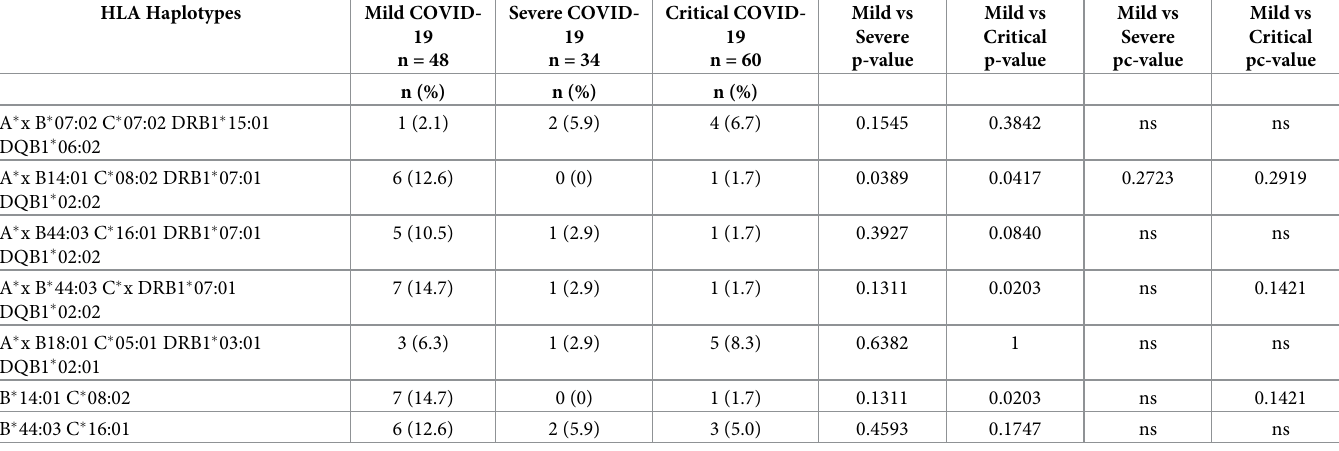
of fifteen KIR loci and two pseudogenes in the groups of individuals with severe and critical COVID-19 in comparison with the group of individuals with mild COVID-19 (Table 5). Association between HLA-C alleles and COVID-19 presentations Some HLA-C alleles can be divided into two large groups according to the amino acids located at positions 77 and 80 when they are considered as ligands for KIRs. Alleles from group C1 contain Ser 77 and Asn 80 (HLA-C � 01; � 03; � 08; � 12; � 14, and � 16), whereas alleles from group C2 contain Asn 77 and Lys 80 (HLA-C � 02; � 04; � 05; � 06; � 07; � 15; � 17, and � 18) [29]. When the frequency of hetero- and homozygosis of HLA-C1 and/or -C2 alleles was analyzed in the Table 4. Most common HLA haplotypes observed in individuals with mild, severe and critical COVID-19. The statistical significance of the comparisons between the frequencies of these haplotypes in the groups of individuals with severe and critical COVID-19 and the group of individuals with mild COVID-19 was calculated using HLA